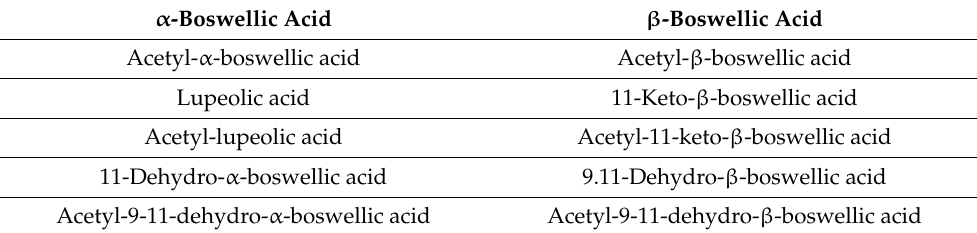
Table 1. The various types of pentacyclic triterpenic acids in Boswellia species extract [185]. α -Boswellic